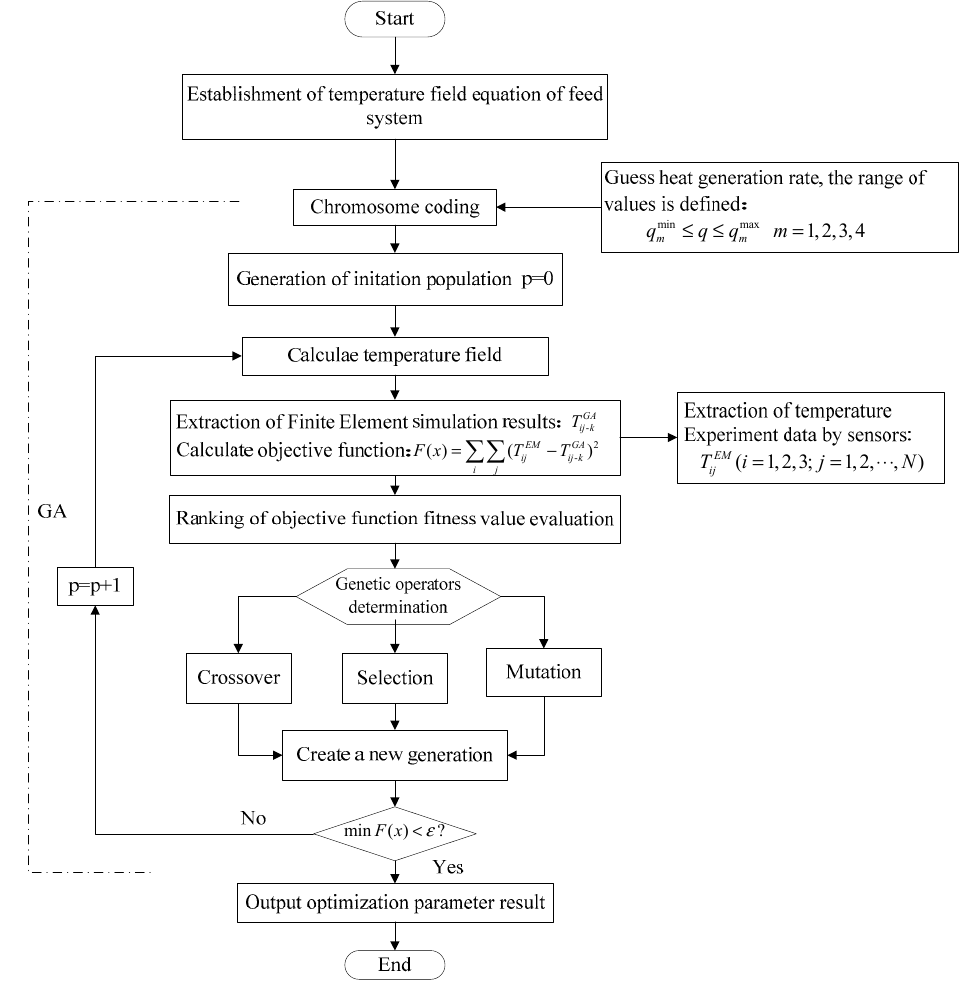
Figure 8. Flow chart of dynamic thermal network combined with GA optimization.